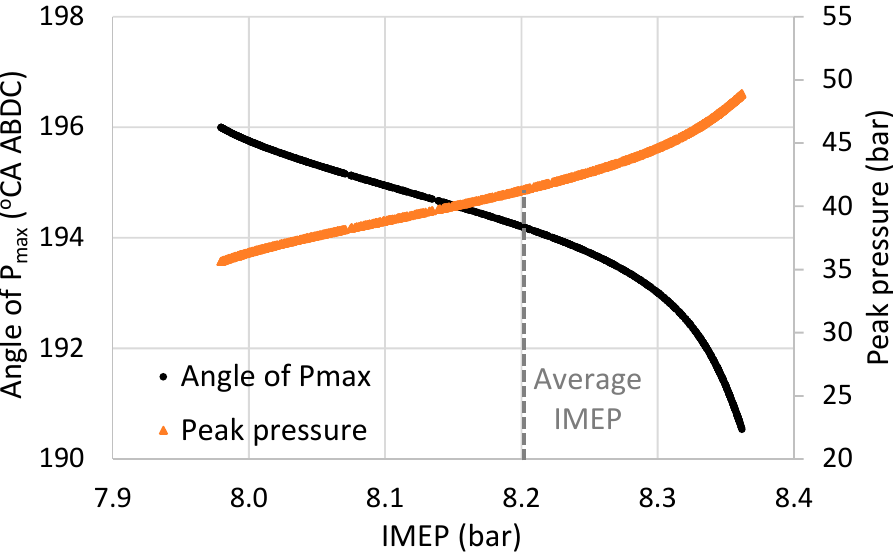
Figure 6. Peak pressure and its angle as a function of the IMEP for the case of 1000 cycles.